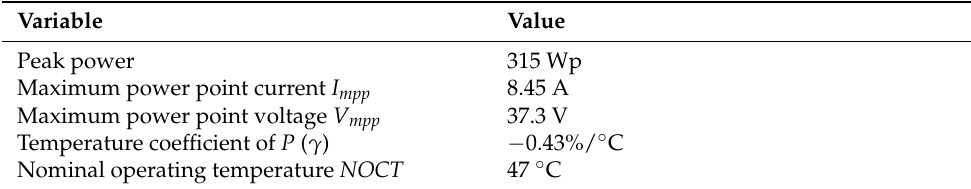
Table 7. Technical characteristics photovoltaic panel A-315M. Data from